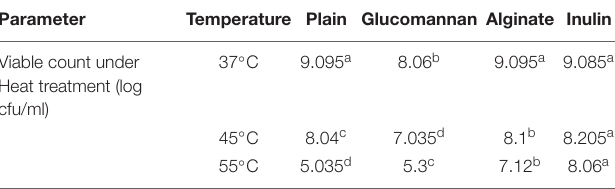
TABLE 2 | Viable count of L. rhamnosus (mean log cfu/ml) when exposed to different heating temperatures for 30 min.